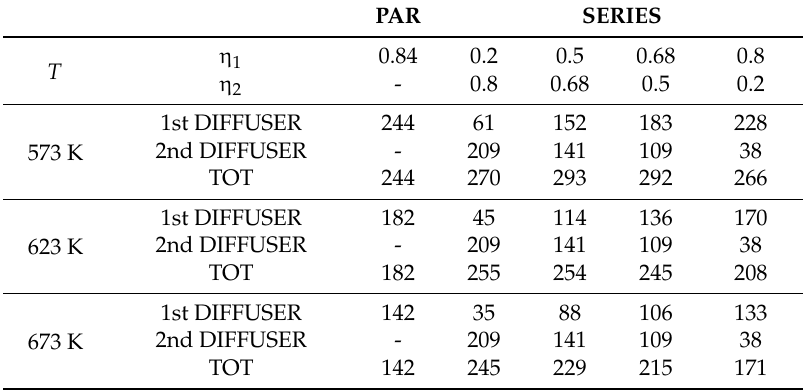
Table 4. Number of tubes required in parallel and series configuration (10 mm diameter, 500 mm length, 0.1 mm thickness).